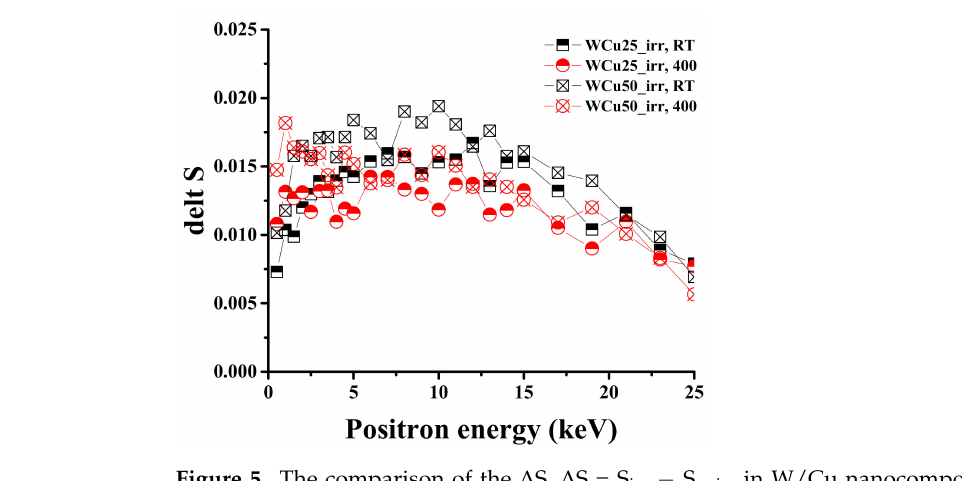
Figure 5. The comparison of the ∆ S, ∆ S = S irr − S unirr in W/Cu nanocomposites with different interfaces